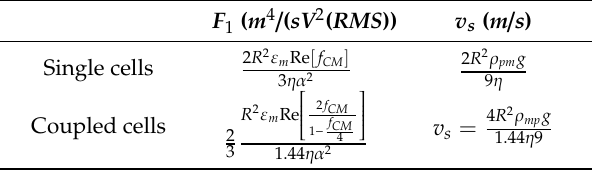
Table 1. Mathematical expressions of F 1 and v s